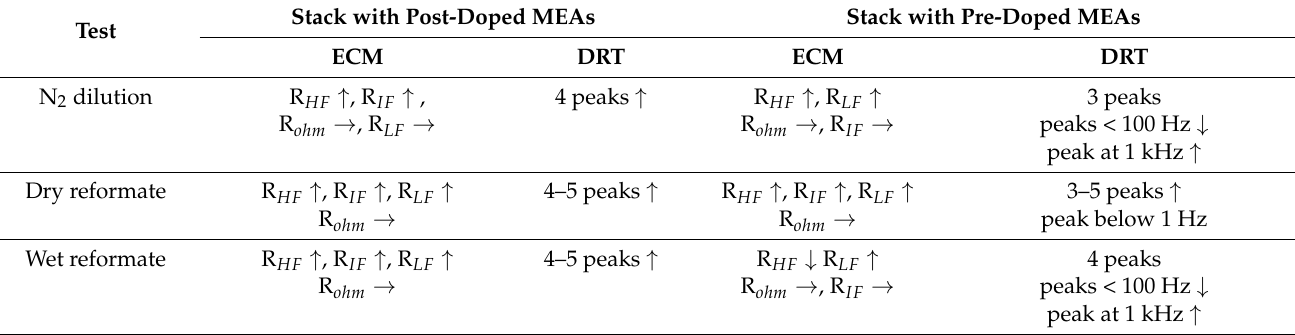
Table 2. The characteristic features of dry and wet reformate in HT-PEMFC stacks. The arrows indicate the overall trends of the parameters, where ↑ represents an increase and → represents no significant